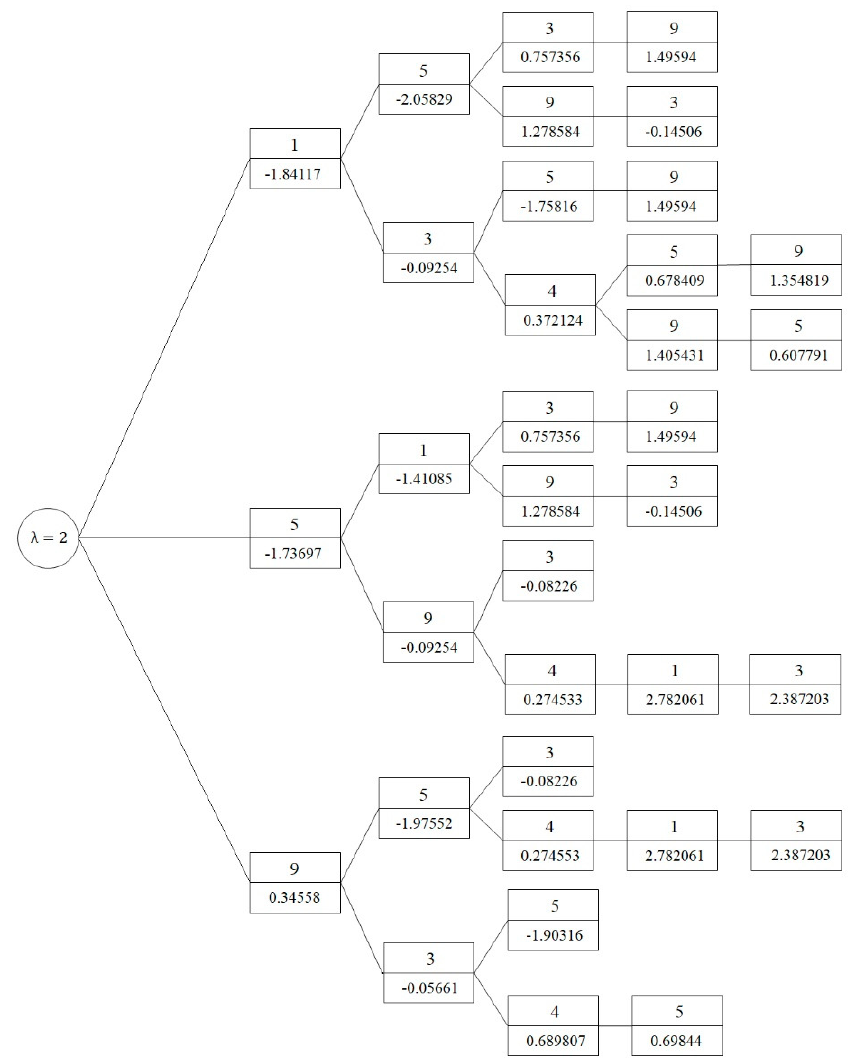
Figure 10. The failure tree and corresponding reliability indices when λ =